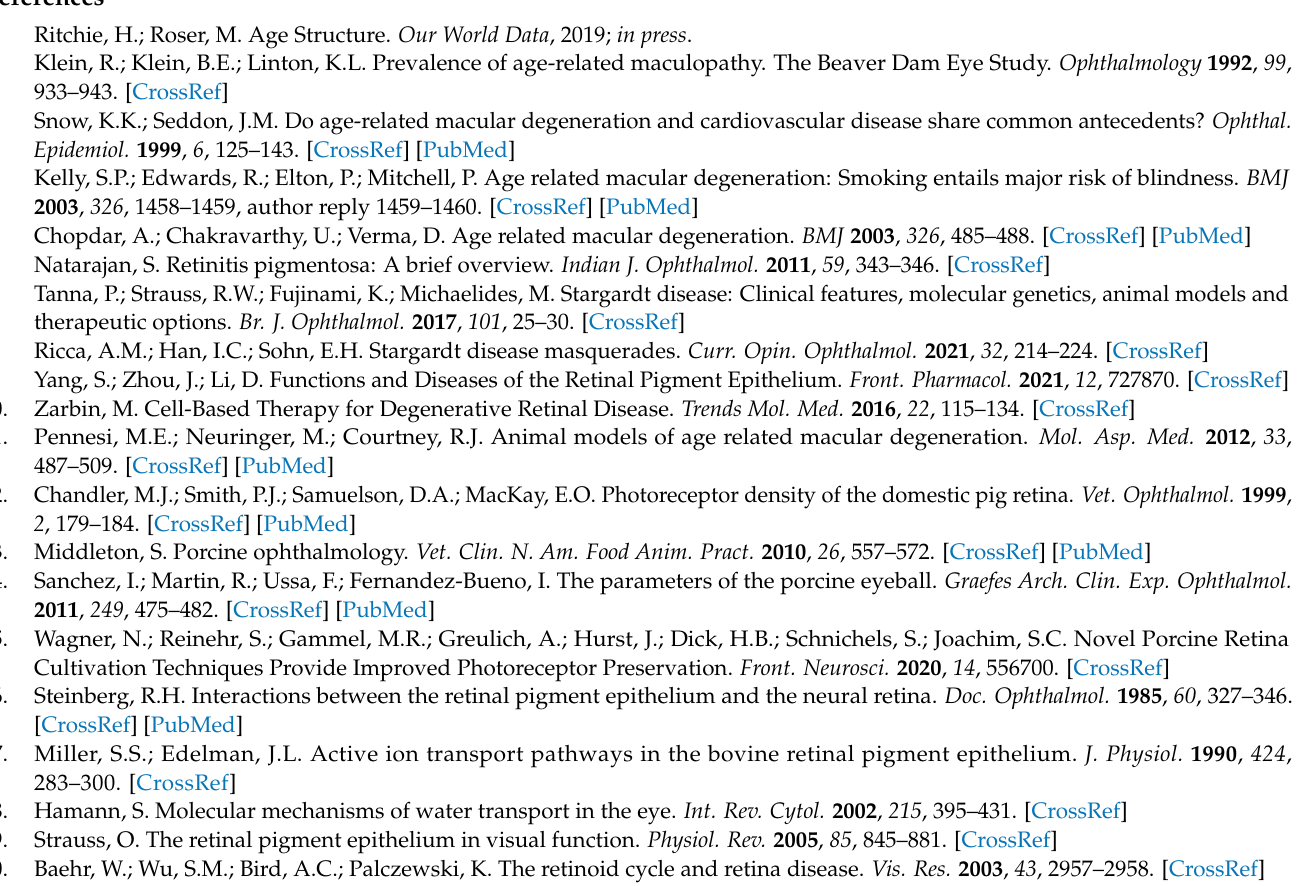
Table S1: List of defined background, lower and upper threshold